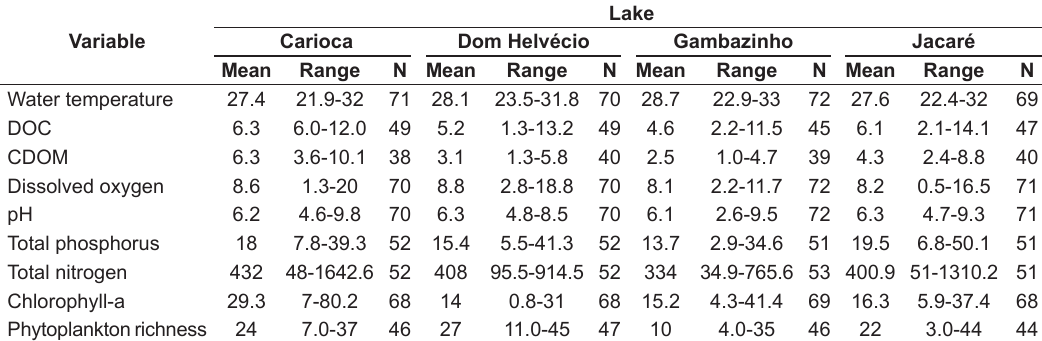
Table 3. Descriptive statistics of the limnological variables measured at Carioca, Dom Helvécio, Gambazinho, and Jacaré